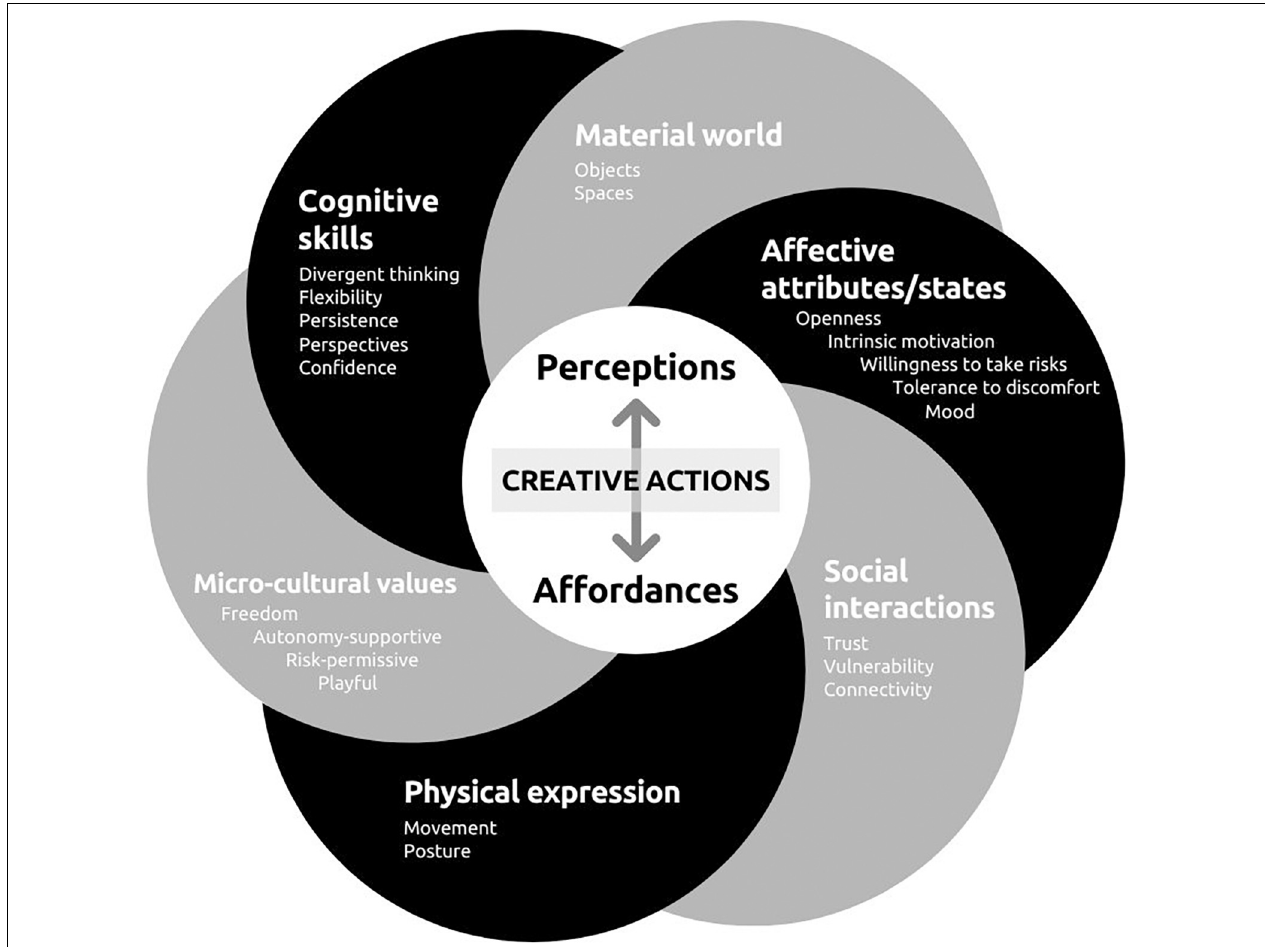
FIGURE 1 | Interacting elements of the creative potential